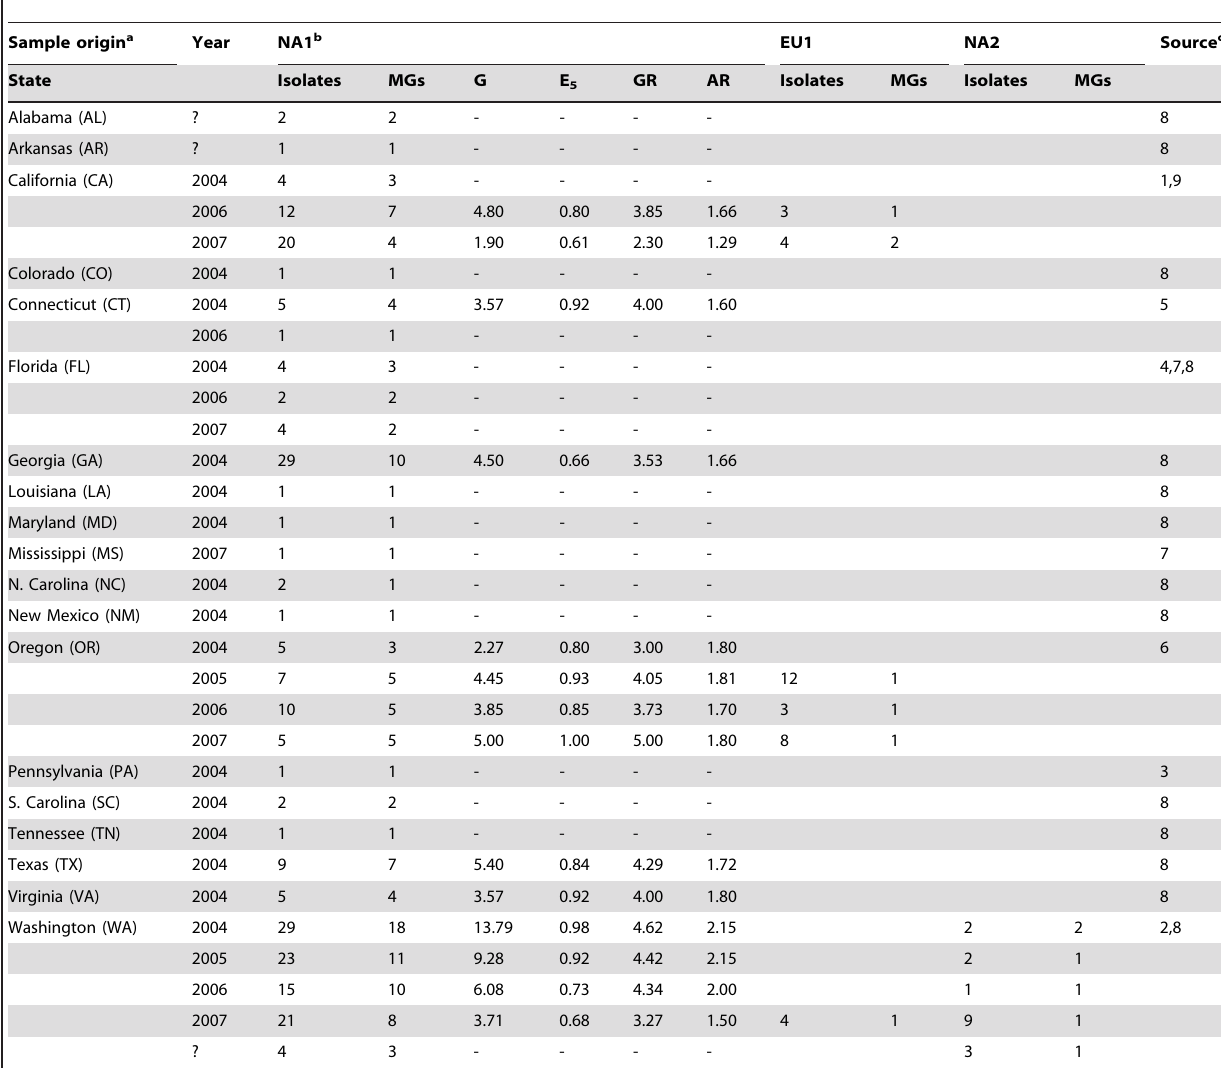
Table 1. Summary of the genetic diversity of P. ramorum nursery isolates by state and year collected.